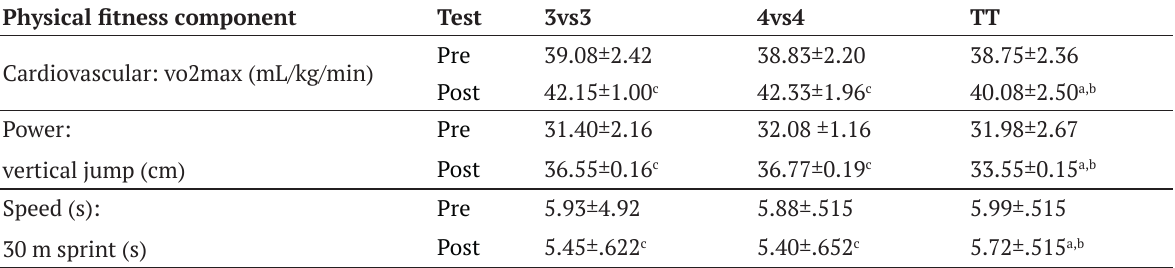
Table 2. Mean and standard deviation for physical fitness component during pre and post-test between group.